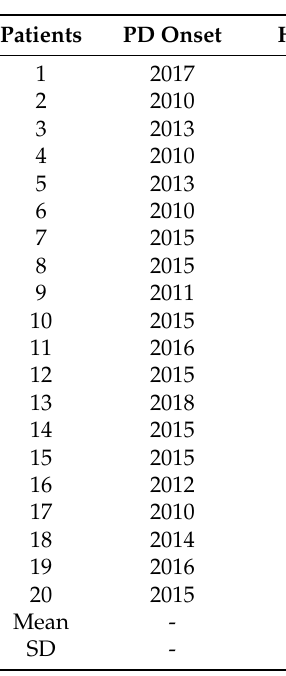
Table 1. Clinical features of patients with Parkinson’s